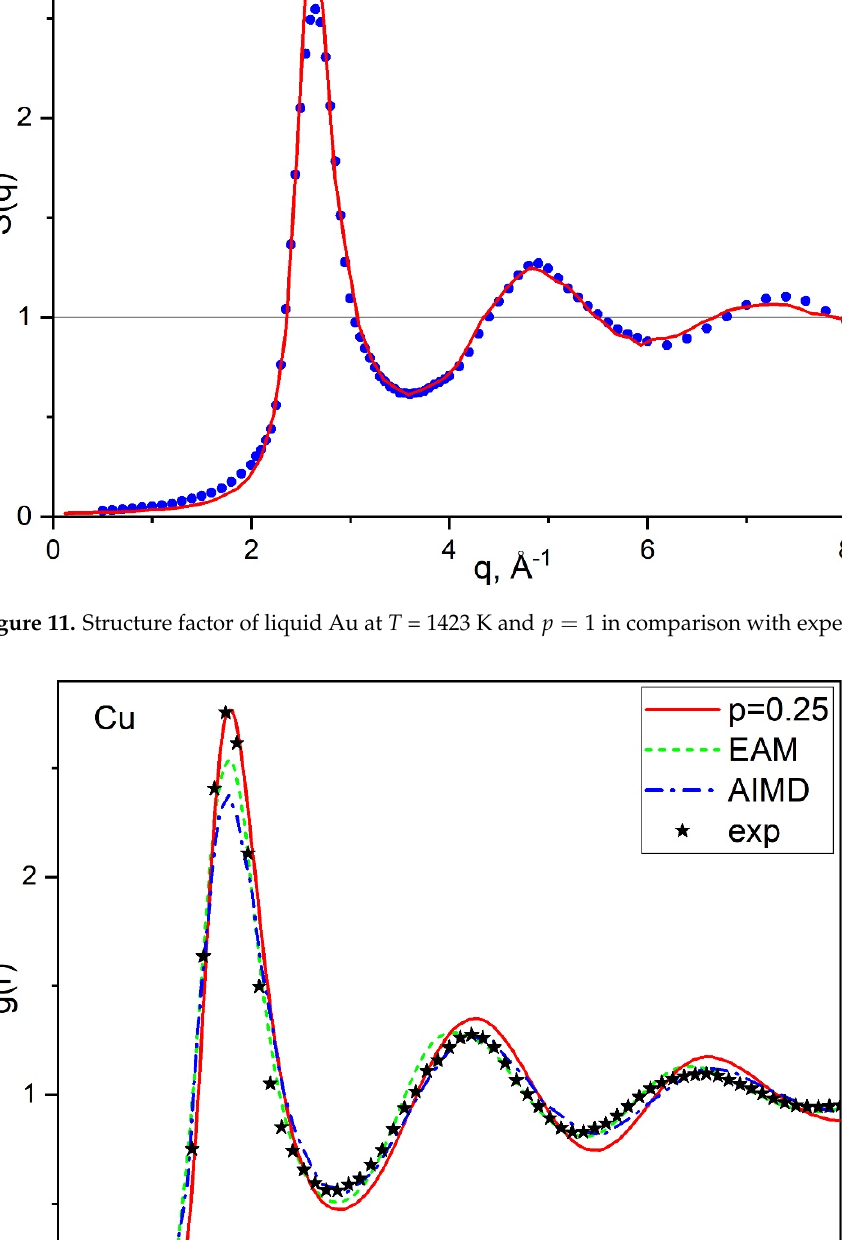
Figure 10. Structure factor of liquid Ag at T = 1273 K and ment [38].